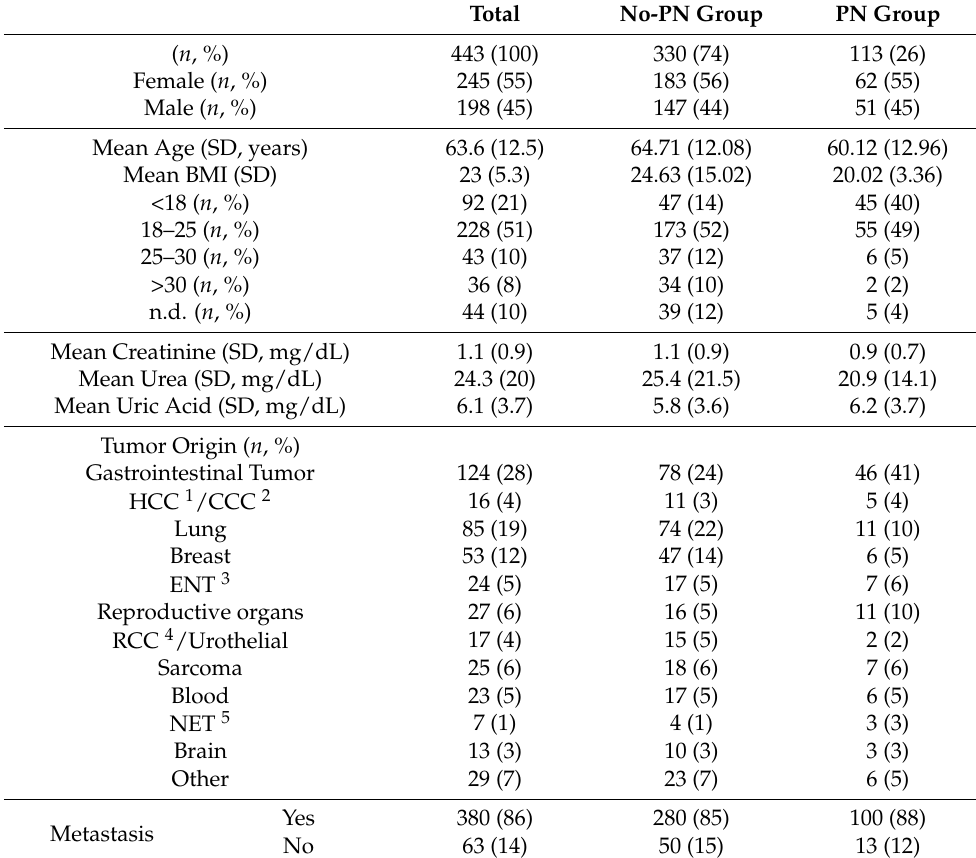
Table 1. Patients’